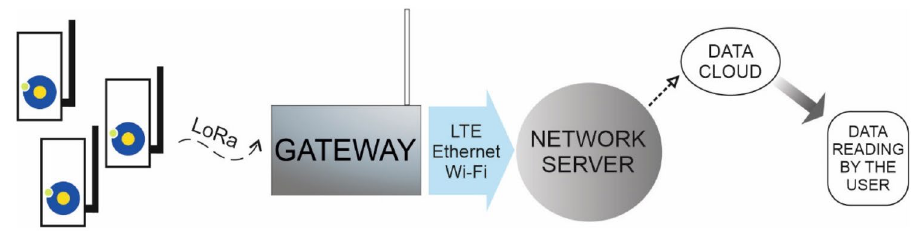
Figure 3. Schematic diagram of the measurement